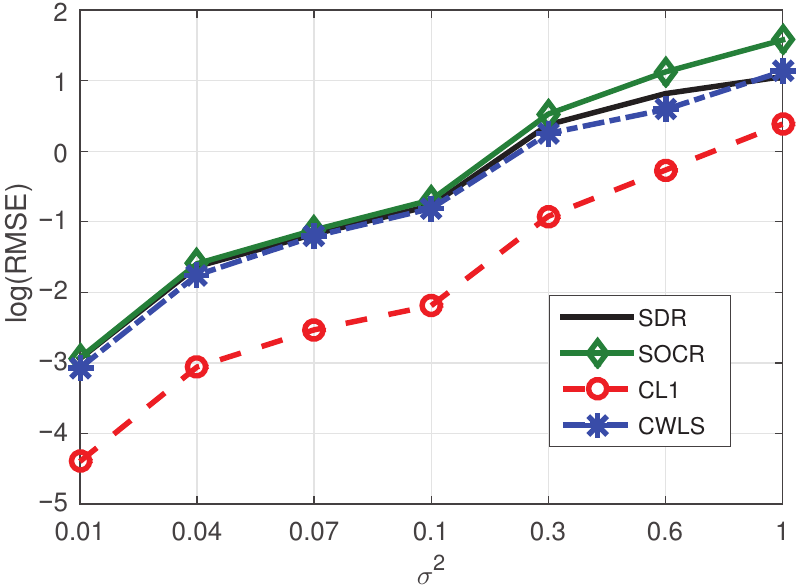
Figure 3. RMSE comparison of four methods under the conditions of seven BSs and one